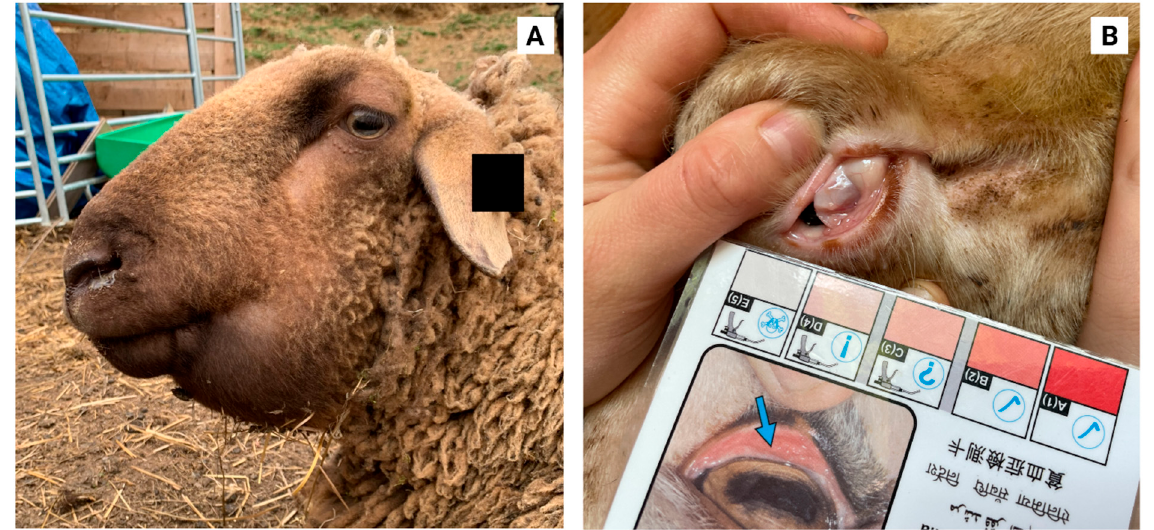
Figure 2. ( A ) An Austrian Jura sheep with typical submandibular oedema (‘bottle jaw’) and ( B ) an East Friesian sheep with pale conjunctiva due to anaemia. Friesian sheep with pale conjunctiva due to anaemia. The instrument in the picture is a FAMACHA © card in non-English. A FAMACHA © card, a laminated colour chart developed in South Africa, is commonly used for the clinical identification of anaemic sheep and